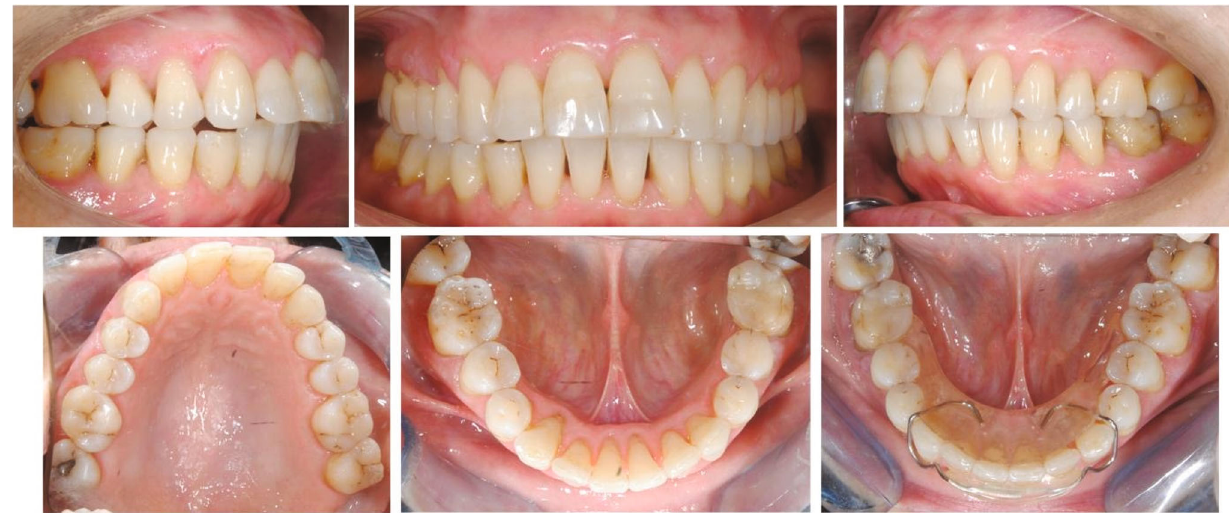
Figure 9: Follow-up after 18 months from the end of the orthodontic